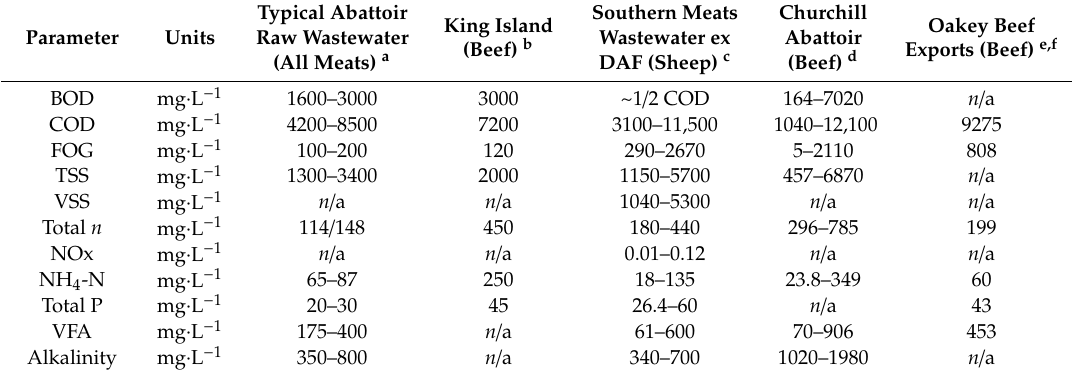
Table 1. Concentrations of parameters of high-strength wastewaters produced by abattoirs amended and adapted from Harris and McCabe